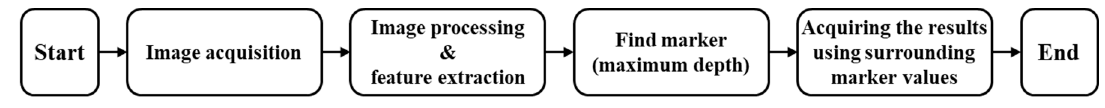
Figure 2. The sequence of data processing to determine contact position and depth.